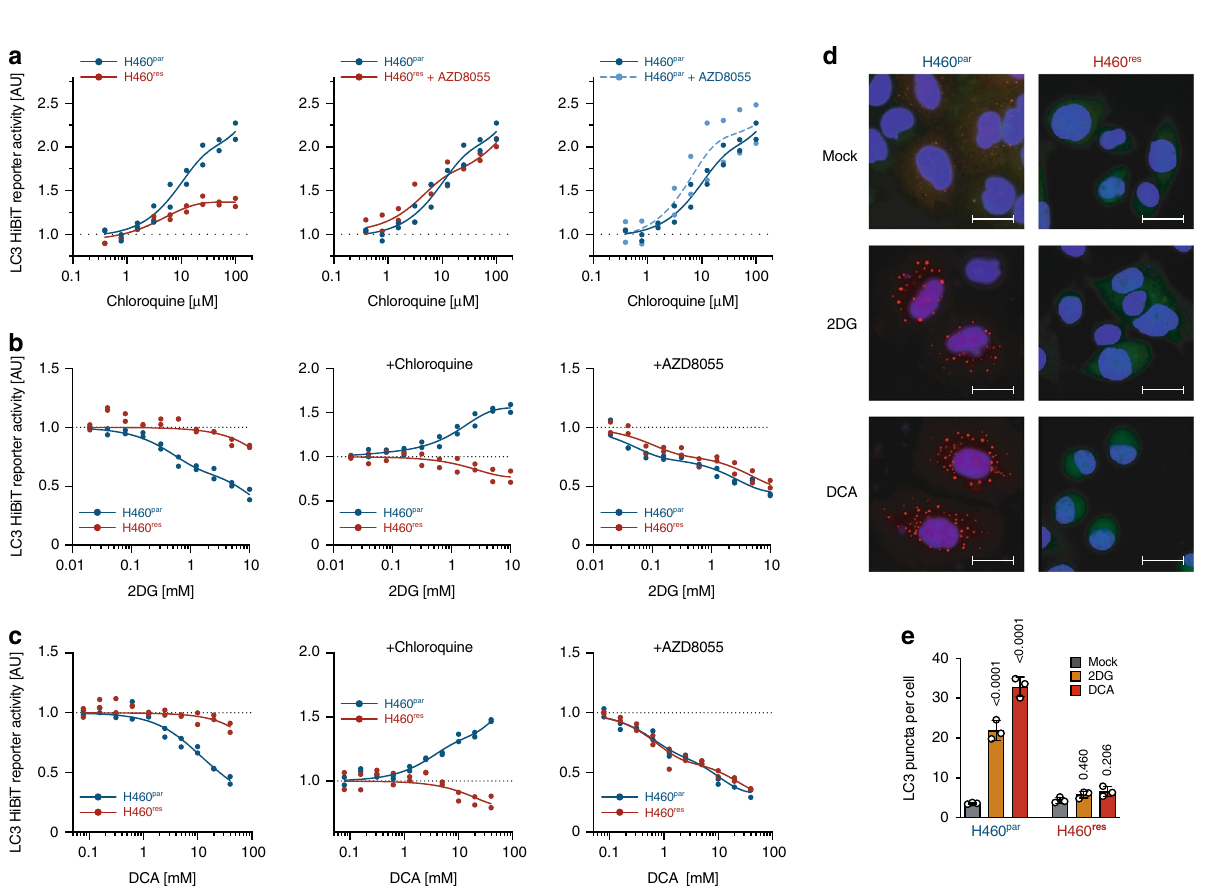
Fig. 3 mTOR-mediated autophagy defect in CDDP-resistant tumor cells. a – c Autophagic fl ux analysis of H460 par and H460 res cells stably transfected with LC3-HiBiT reporter. a Cells were pre-treated with AZD8055 for 48 hours before adding the indicated doses of chloroquine for 6 hours. b , c Cells were pre-treated as indicated with chloroquine or AZD8055 for 48 hours before adding increasing doses of b 2DG or c DCA for 6 hours. Shown is reporter activity measured as LC3-HiBiT luminescence normalized to untreated of n = 2 replicates. d , e H460 cells were transfected with DsRed-LC3-GFP, which yields a diffuse cytoplasmic green fl uorescence that, upon autophagy induction, shifts to red- fl uorescent puncta marking autophagosomes 25 . d Representative immuno fl uorescence images of DsRed-LC3-GFP-expressing cells following 48 hours treatment. Scale bars, 10 µ m. e Quanti fi cation of d . Shown are mean ± SD, n = 3 independent experiments in each of which 100 cells were quanti fi ed, two-way ANOVA with Dunnet ’ s multiple comparisons